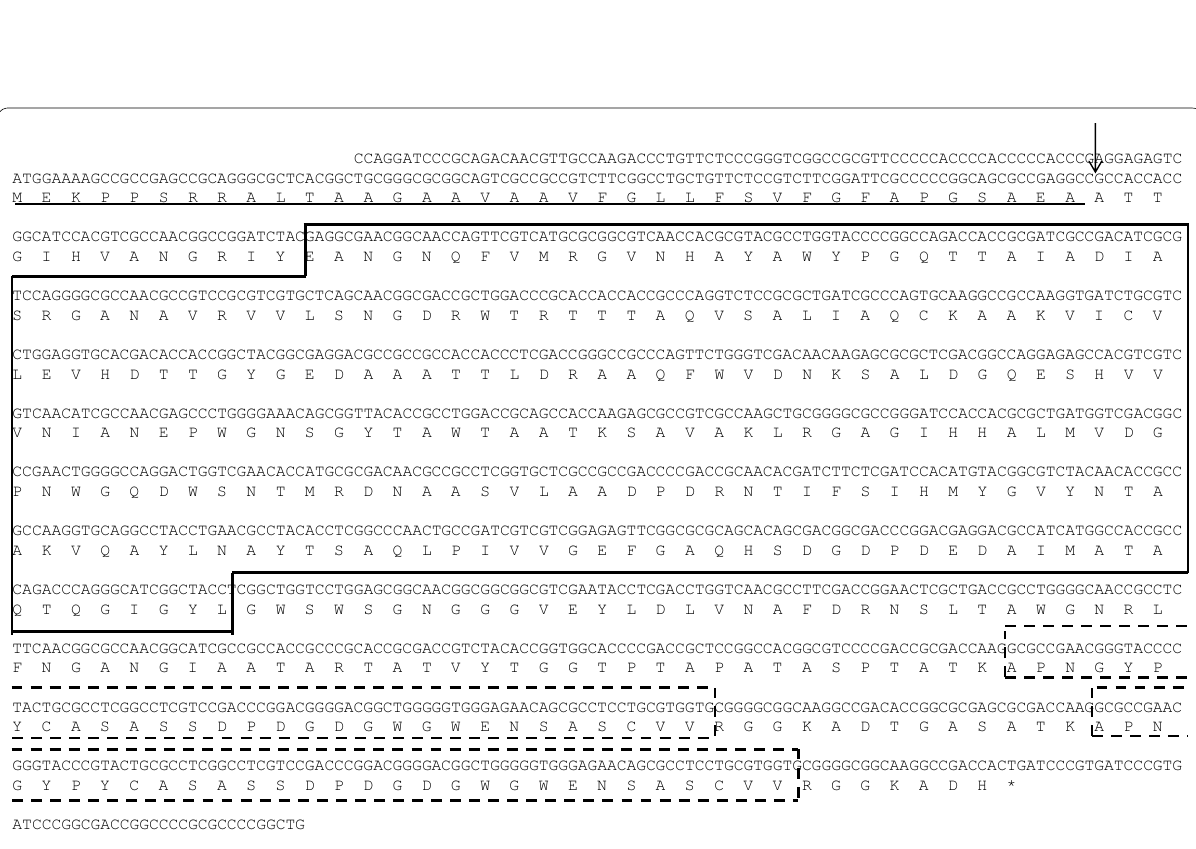
Fig. 3 Nucleotide and deduced amino acid sequences of ManKs_4‑555 from ID04‑0555. Stop codon is indicated by the asterisk . The underline and down arrow represent the signal peptide and cleavage site, respectively. The box and the dotted boxes represent putative catalytic domain and puta‑ tive carbohydrate‑binding modules,